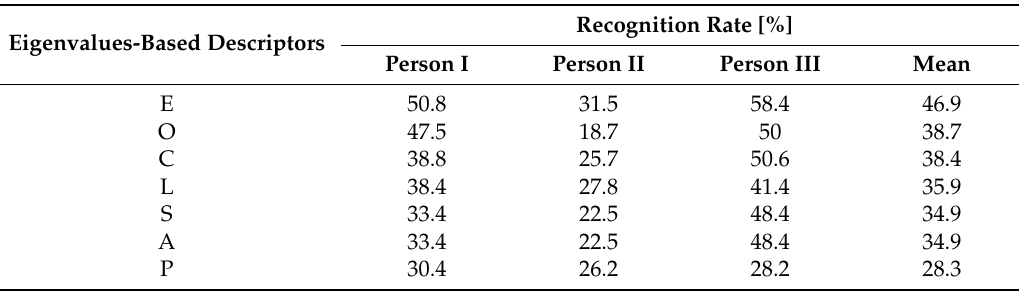
Table 2. Recognition rates (sorted in descending order by mean rate) of the method independent from the acronym dictionary using single eigenvalues-based descriptors. The results were obtained for the model B 2 with T as the training set and A as the testing set.